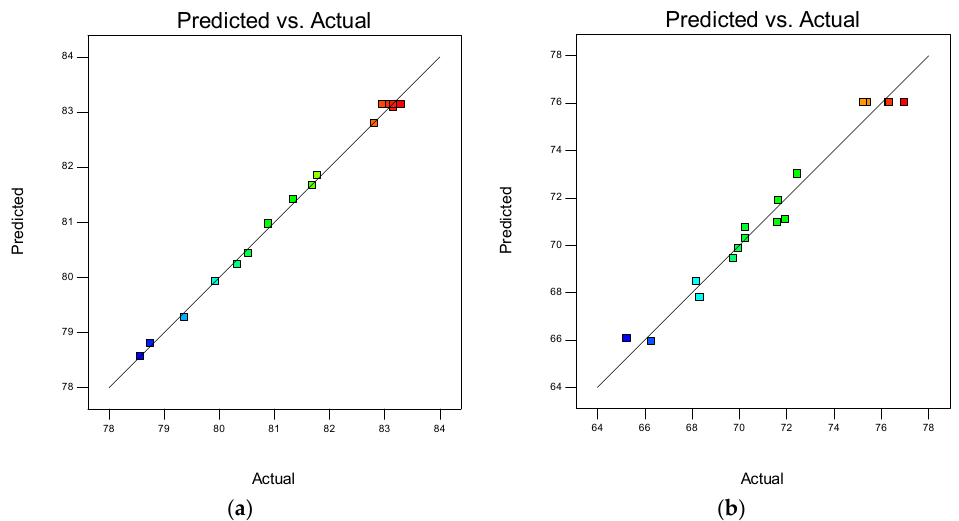
Figure 6. Residual plots of Fe and Mn ions ( a ) and plots of predicted vs. actual values ( b ).